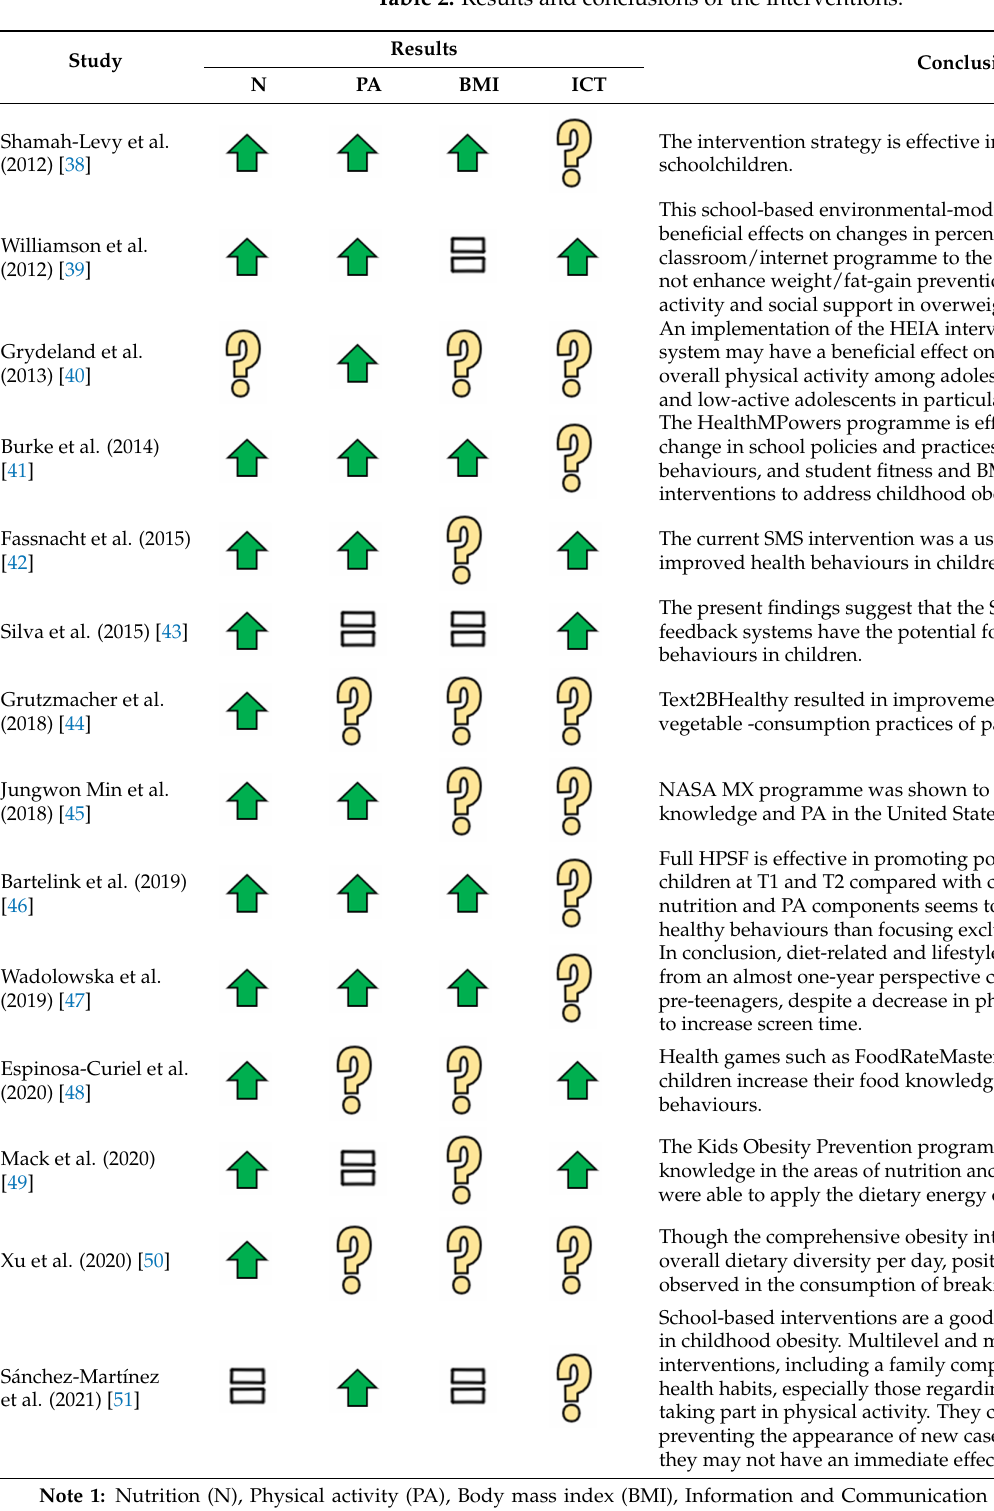
Table 2. Results and conclusions of the